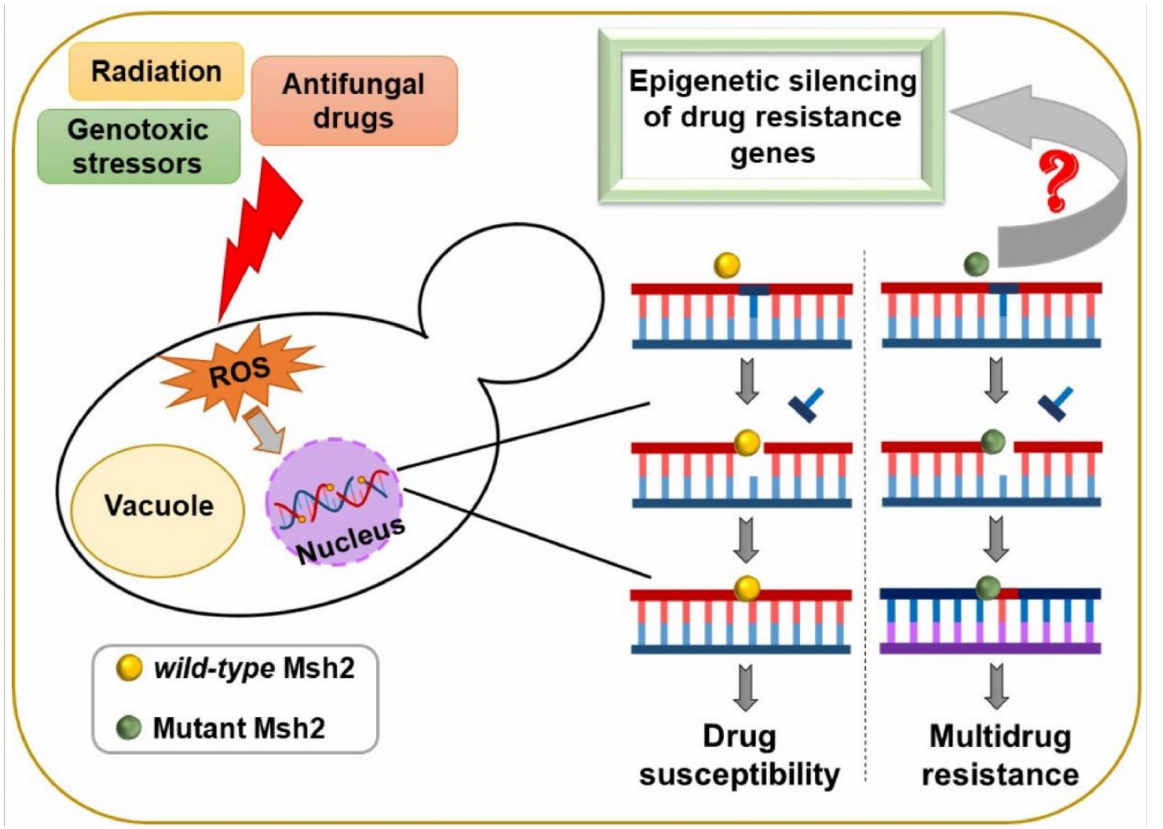
Figure 3. A possible link between the DNA mismatch repair system and antifungal resistance